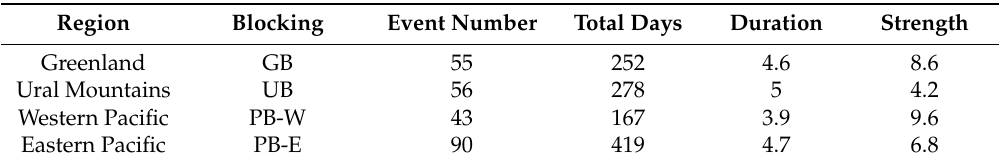
Table 1. Blocking events in each region for winters from 1979–2016 associated with their total blocking days, mean duration (days) and strength (m (deg lat) − 1 ).